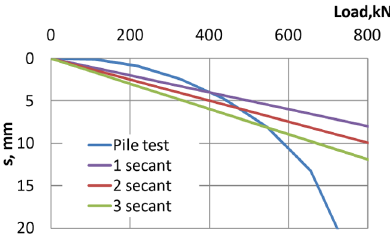
Fig. 5. Static load test curve of the pile stiffness coefficient versus the 1 st pile